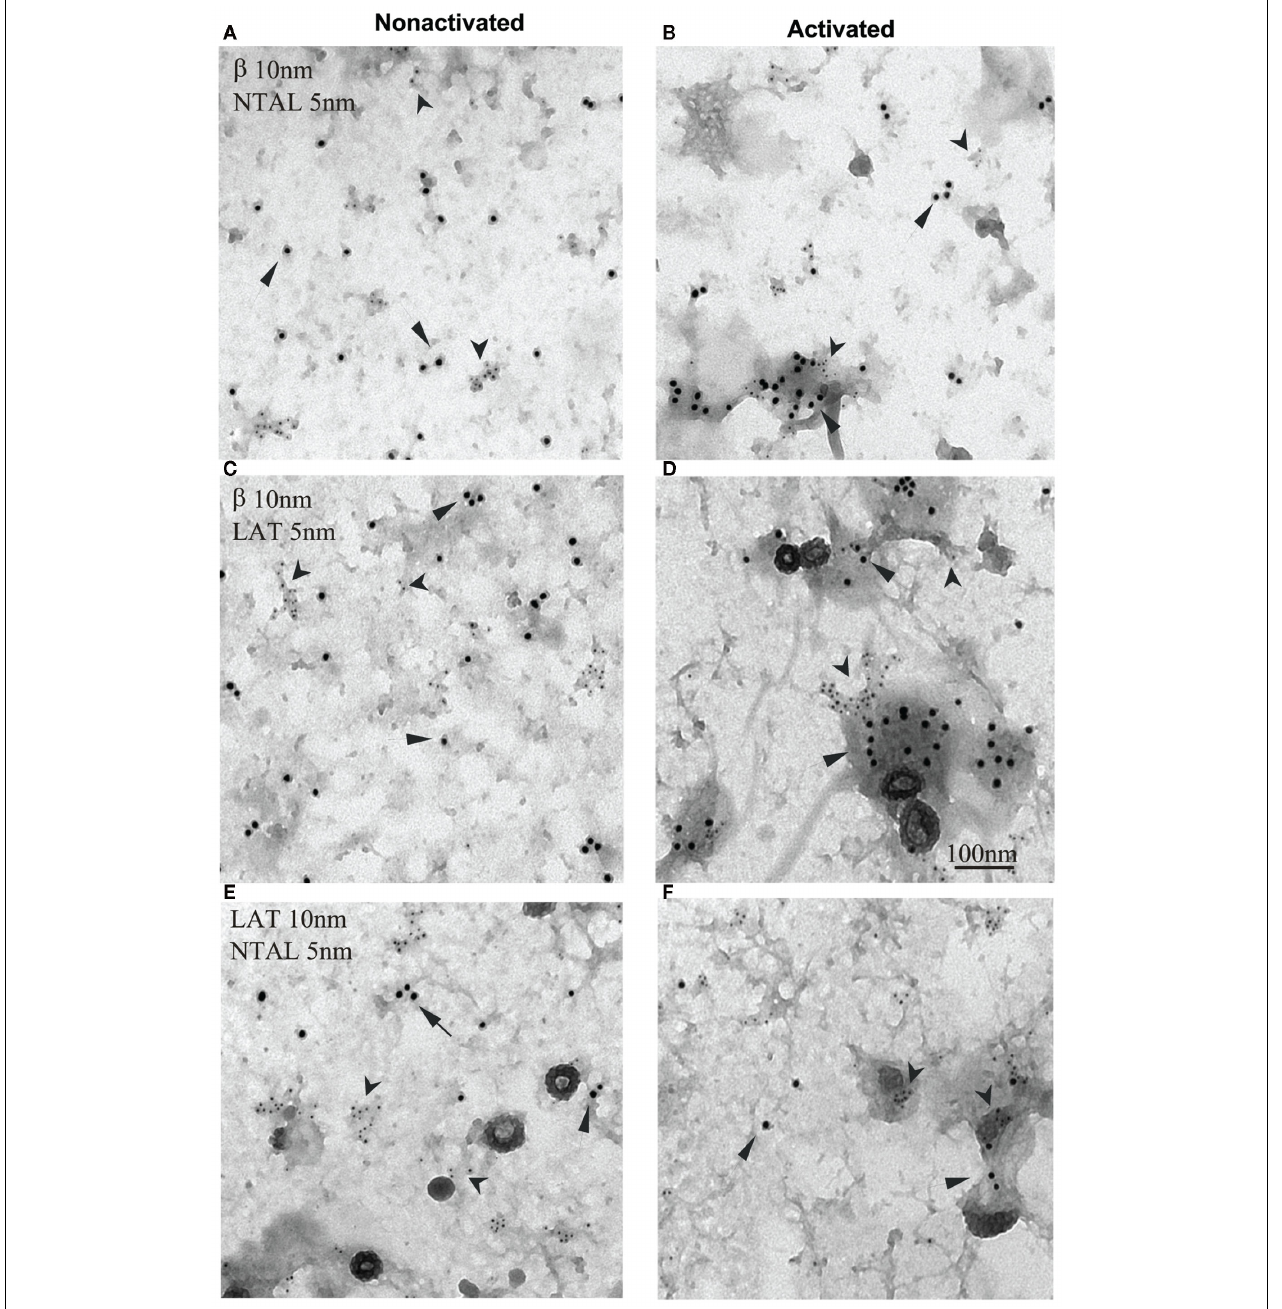
Fc ε RI β subunit labeled with 10nm gold (arrows) and NTAL labeled with 5nm gold (arrowheads). (C,D) Fc ε RI β subunit labeled with 10nm gold (arrows) and LAT labeled with 5nm gold (arrowheads). (E,F) LAT labeled with 10nm gold (arrows) and NTAL labeled with 5nm gold (arrowheads). Scale bar in (D) , 100nm. Originally published in Journal of Experimental Medicine (Volná et al., 2004) where all experimental procedure details have been described.